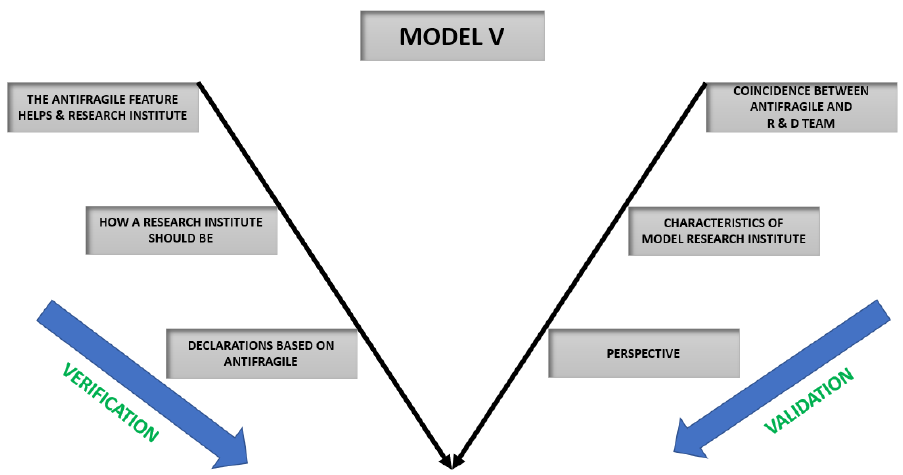
Figure 4. Evaluation and planning model